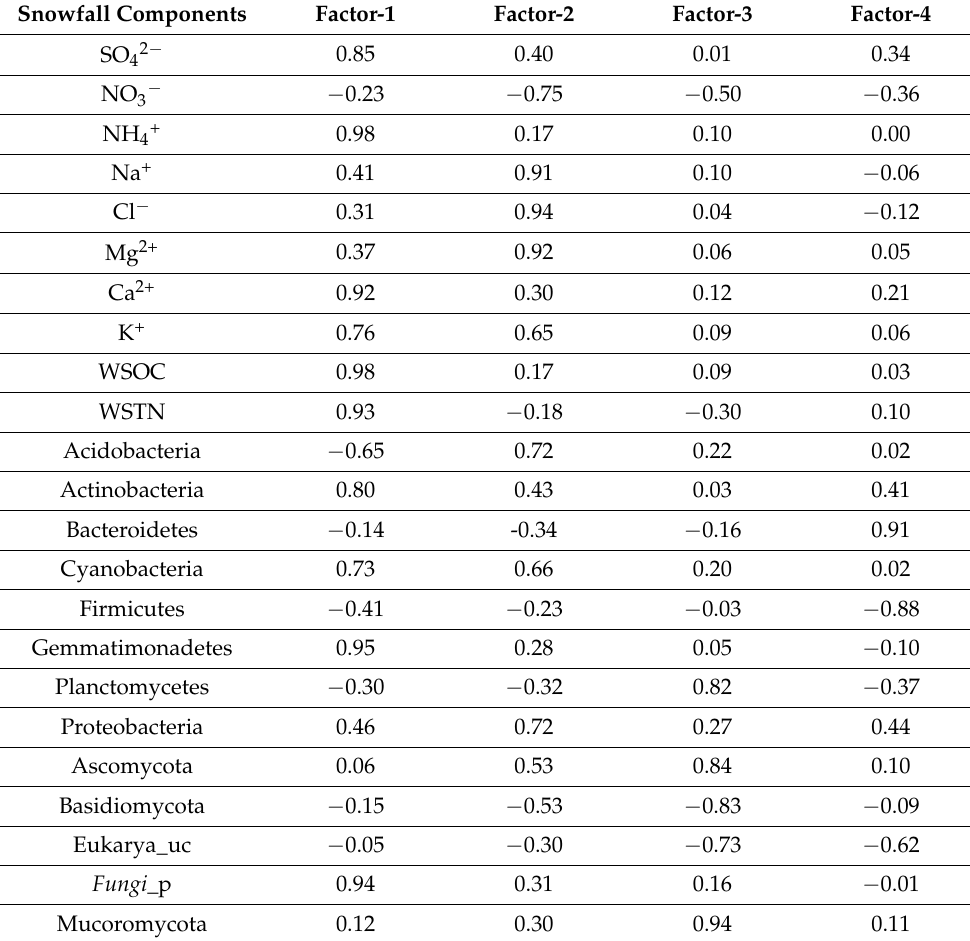
Table 3. Principal component analysis (PCA) with orthogonal rotation (Varimax) with Kaiser normal- ization of the components of the snowfall samples collected at Daejeon, South Korea. Snowfall Components Factor-1 Factor-2